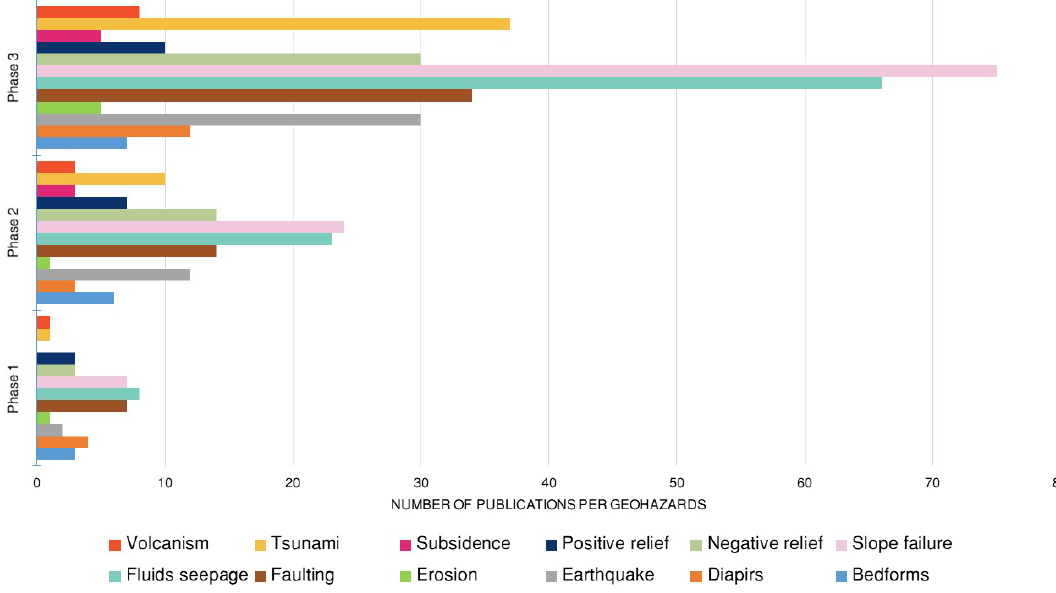
Figure 17. Number of publications between 1982 and 2016 for each category of marine geohazard.